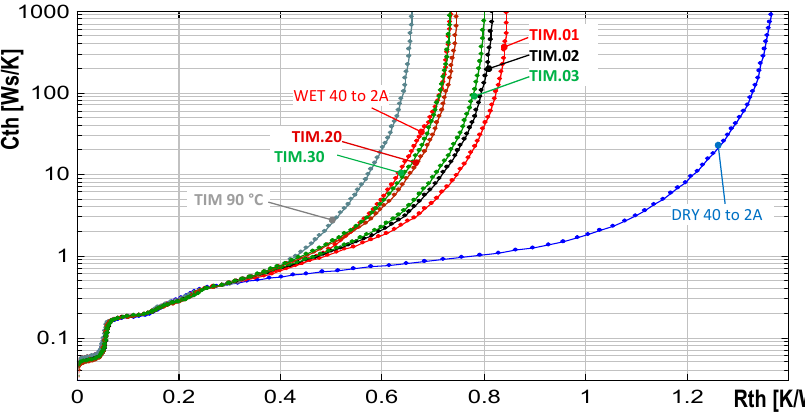
ff ect of a soft thermal Figure 19. Run-in and curing effect of a soft thermal paste. Figure 19. Run-in and curing e